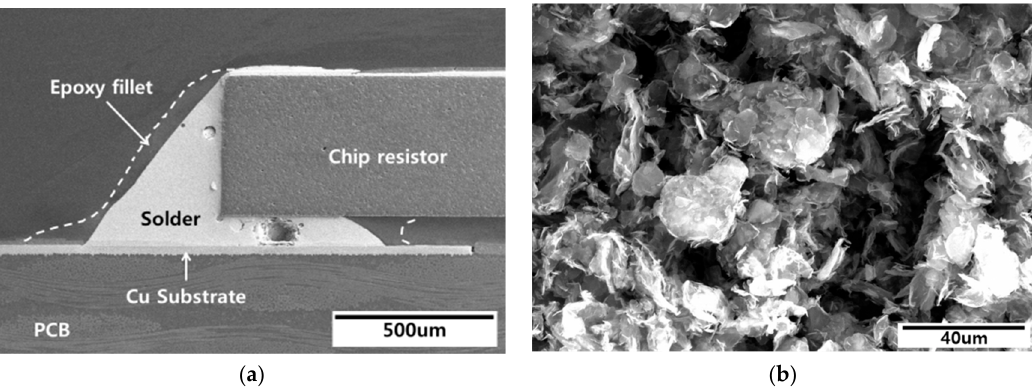
Figure 1. SEM images of ( a ) the structure of the specimens and ( b ) graphene nano-sheets (GNSs).